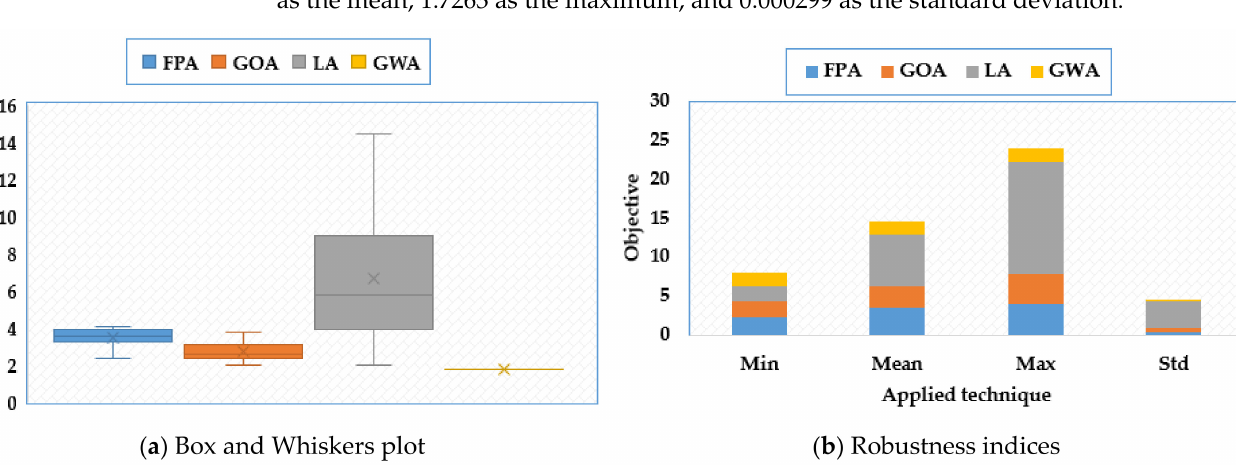
Figure 15. Statistical assessment of GWA, FPA, LA, and GOA for WBD under first